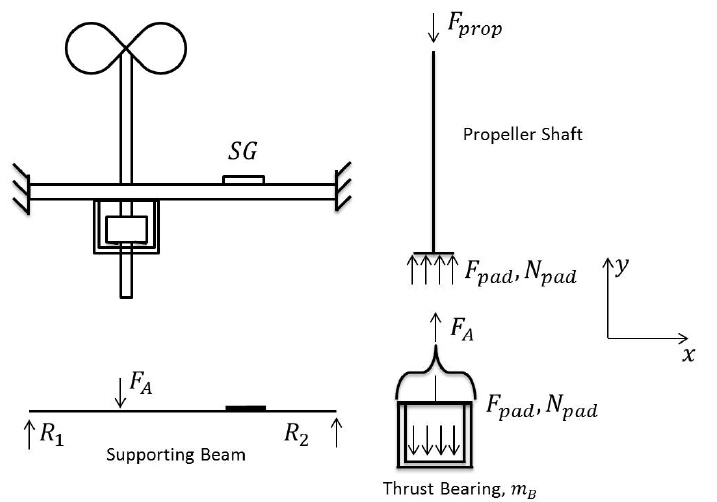
Figure A1. Schematics of the propulsion system ( top left ) and the free body diagrams (FBD) of the propeller shaft ( top right ), thrust bearing ( bottom right ) and the supporting beam structure ( bottom left